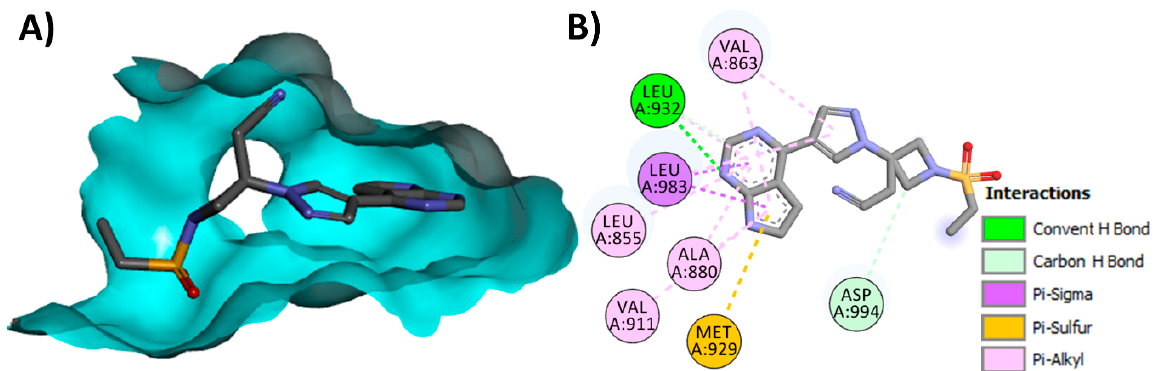
Figure 20. Binding modes of baricitinib (shown as sticks) into human JAK2 JH1 (pdb: 6WTO): ( A ) 3D binding mode, receptor shown as a hydrogen bond surface; ( B ) 2D binding mode showing different types of interactions with JAK2 JH1; the figure was generated using Discovery Studio Visualizer (V16.1.0.15350).